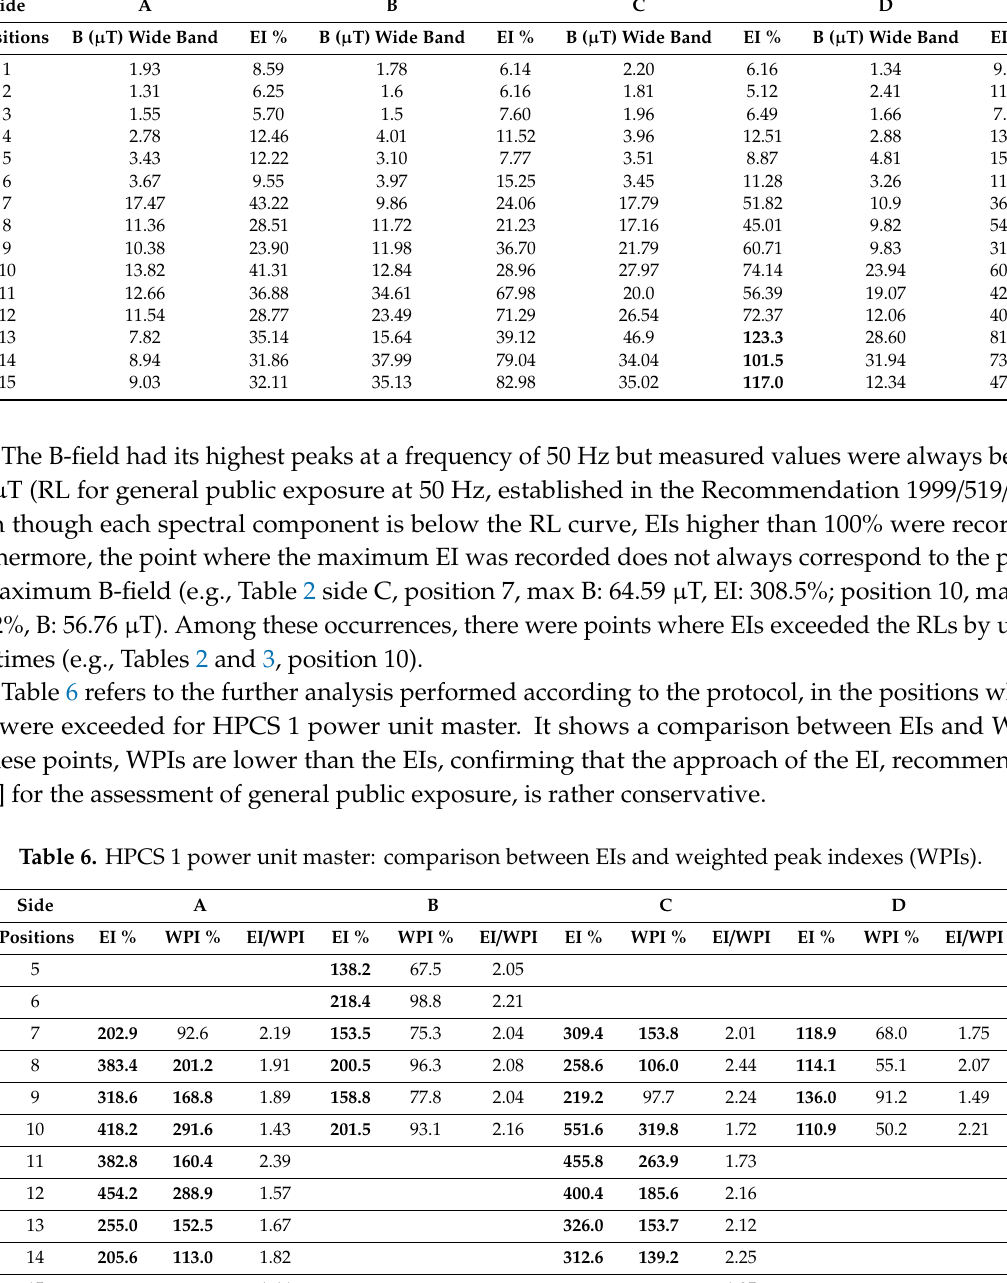
Table 5. B-field and EIs according to the measurement grid for the power unit slave, HPCS 2. Side A B C D Positions B ( µ T) Wide Band EI % B ( µ T) Wide Band EI % B ( µ T) Wide Band EI % EI % 1